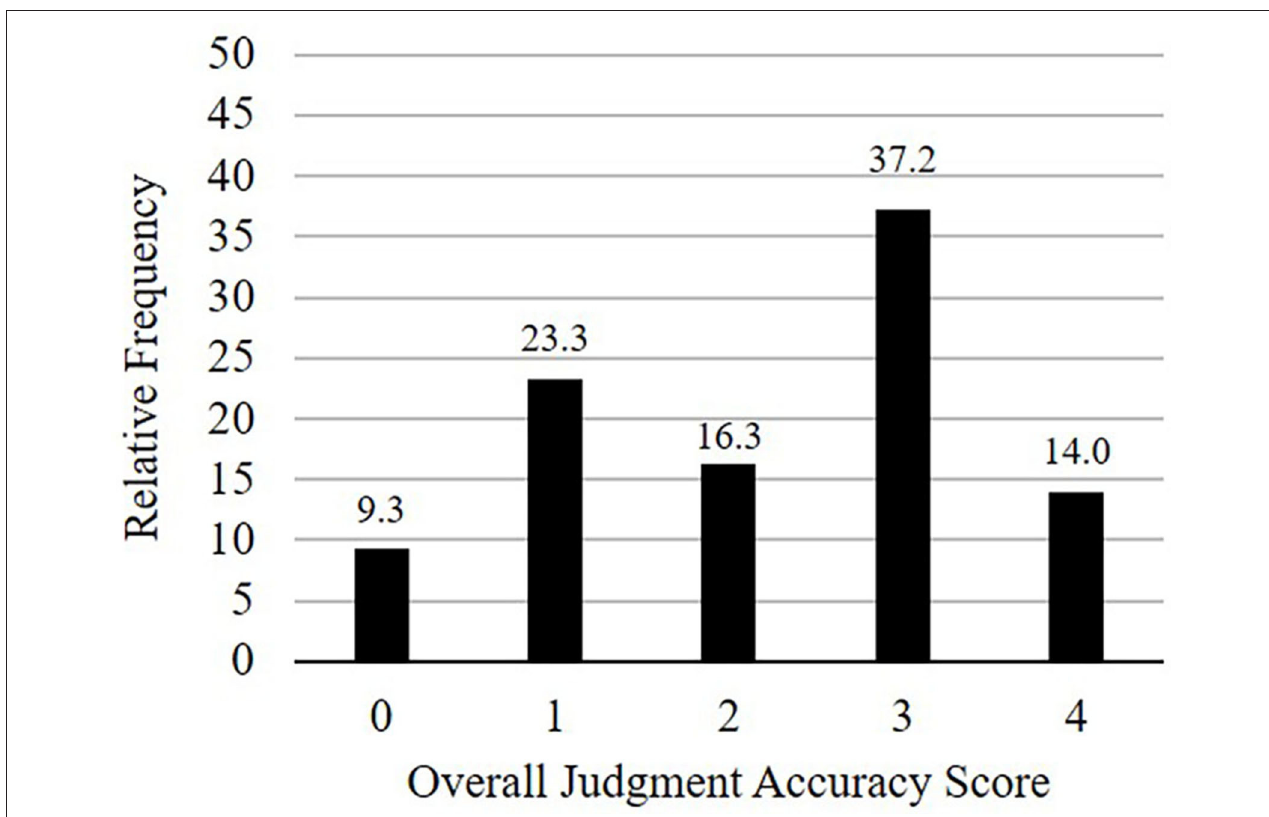
FIGURE 3 | Distribution of overall judgment accuracy